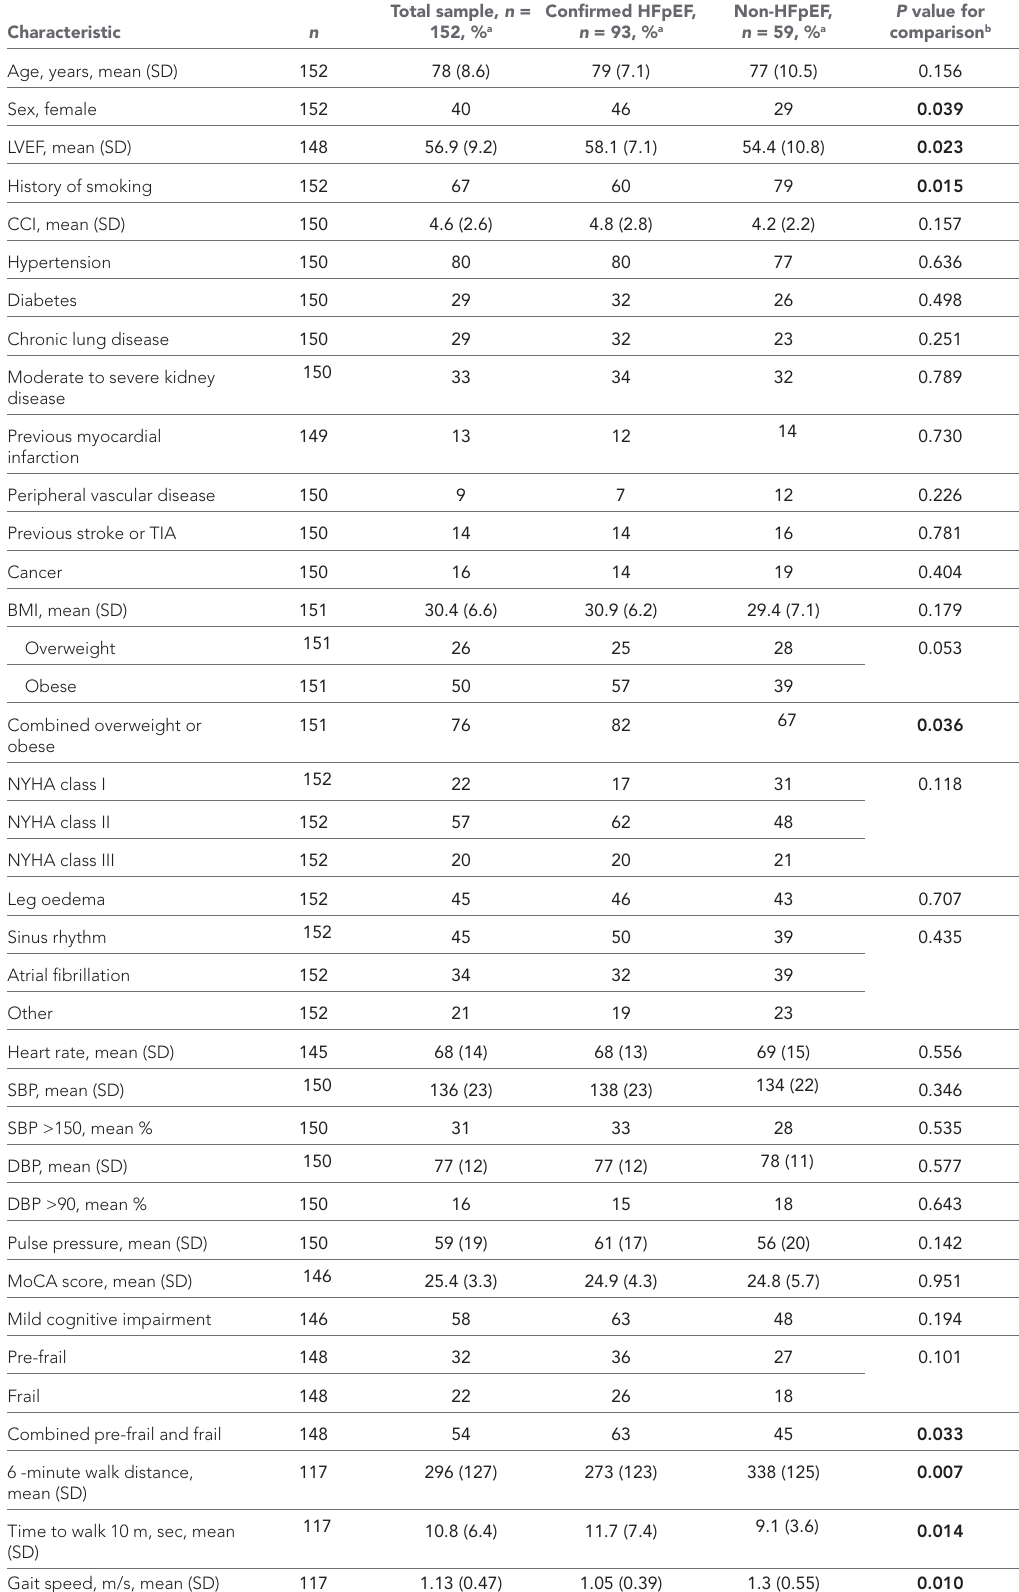
Table 1 Characteristics of sample and by HFpEF